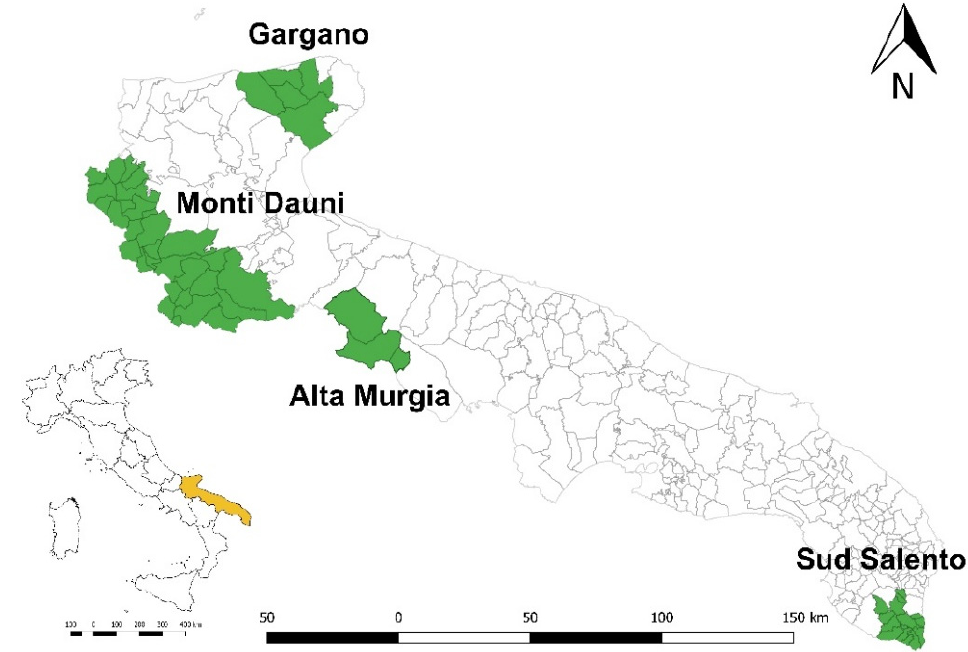
Figure 1. The case study areas.